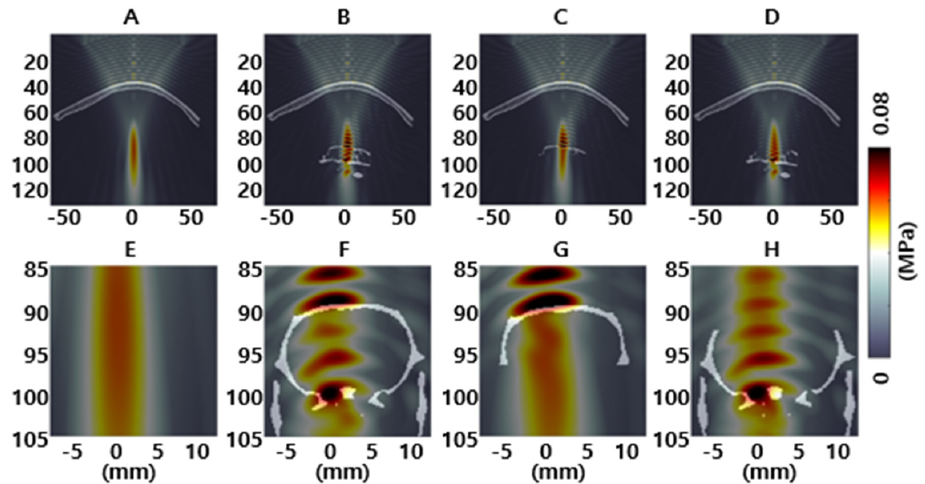
Figure 9. Acoustic distributions at 250 kHz are depicted in ( A – D ) sagittal and ( E – H ) coronal views after transcranial transmission of the ( A , E ) human skull ( B , F ) human with rat skull, and human skull fragment with rat skull excluding their ( C , G ) bottom or ( D , H ) upper